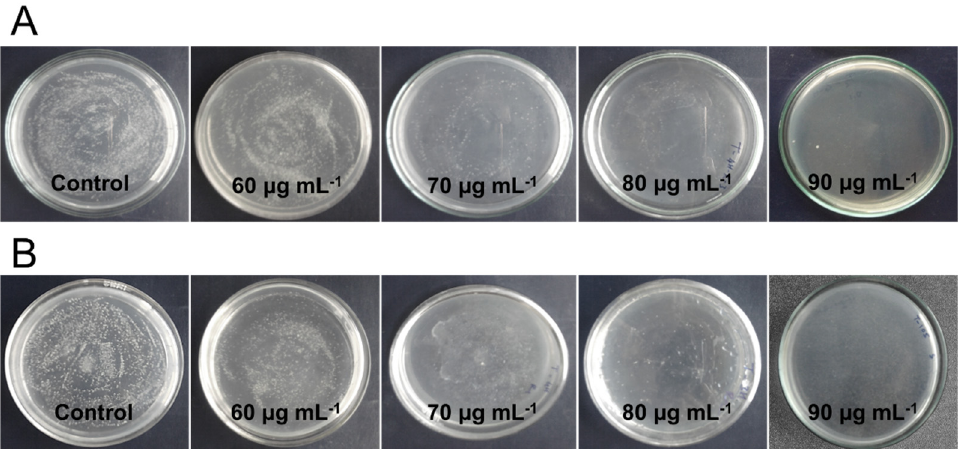
Figure 6. Growth plate photographs of ( A ) S. aureus and ( B ) E. coli with various concentrations of Ag-BSiO 2 -Fe 2 O 3 hybrid structure.